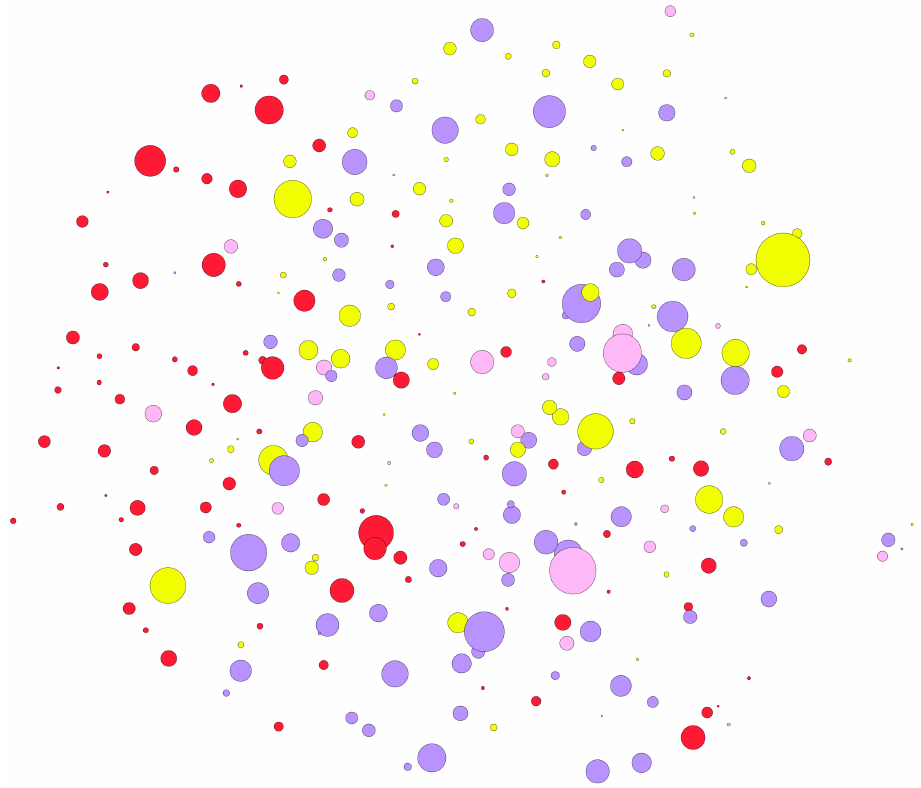
Figure 8. A simplified view of the network of citations, displaying only nodes and links, with the labels removed to improve readability. The complete network with the names of the authors is available in Supplementary Material S8 and allows on-screen zoom for improved reading. In the network, each node represents a document and each link represents a citation (e.g., the references included in each document). The size of the circle is proportional to the centrality of the document, or how many papers cite such specific document. Colors represent clusters, as sets of references that cite some papers more frequently than others. The red color represents the scientific literature on the topic mainly involved in laboratory studies; the yellow color refers mainly to documents dealing with field studies. Other categories are of difficult classification and are built up by studies that integrate both laboratory and field